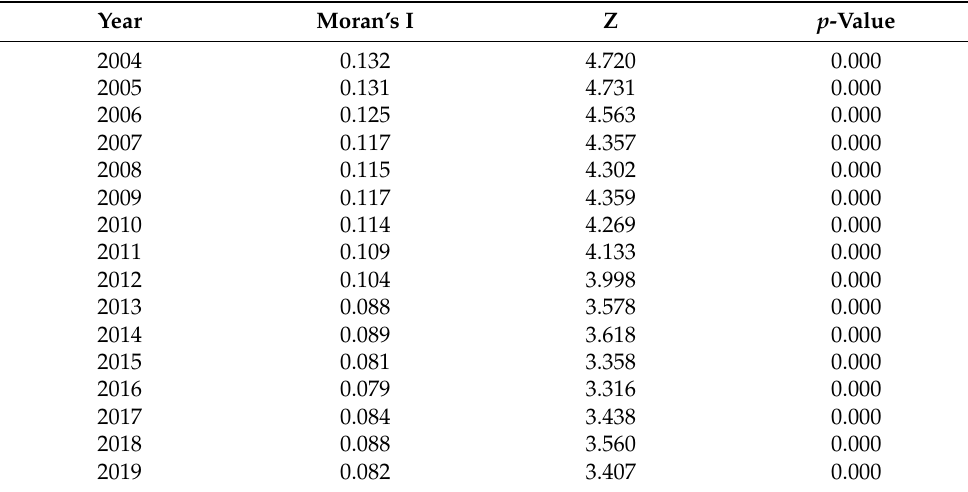
Table 1. The global Moran’s I index of inter-provincial energy efficiency and its